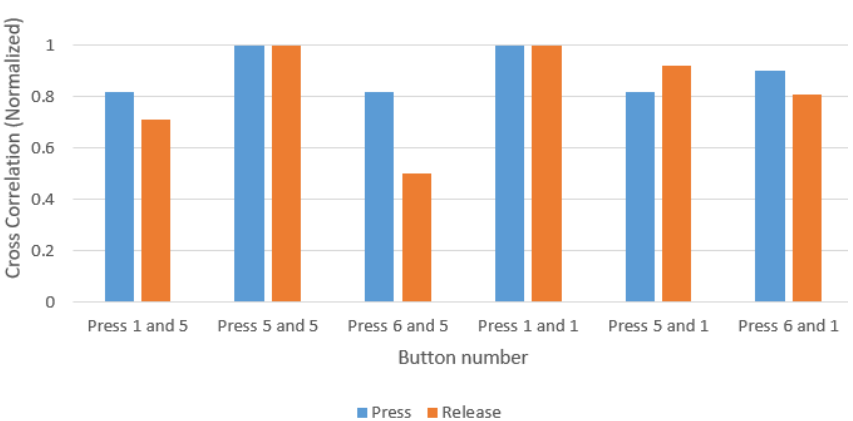
Figure 9. Similarity of press and release of key “5” with key